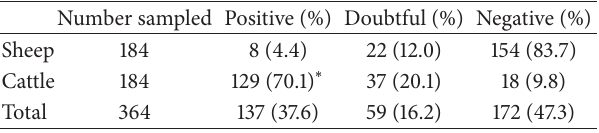
Table 1: Prevalence of AKAV antibodies in sheep and cattle in the study area.